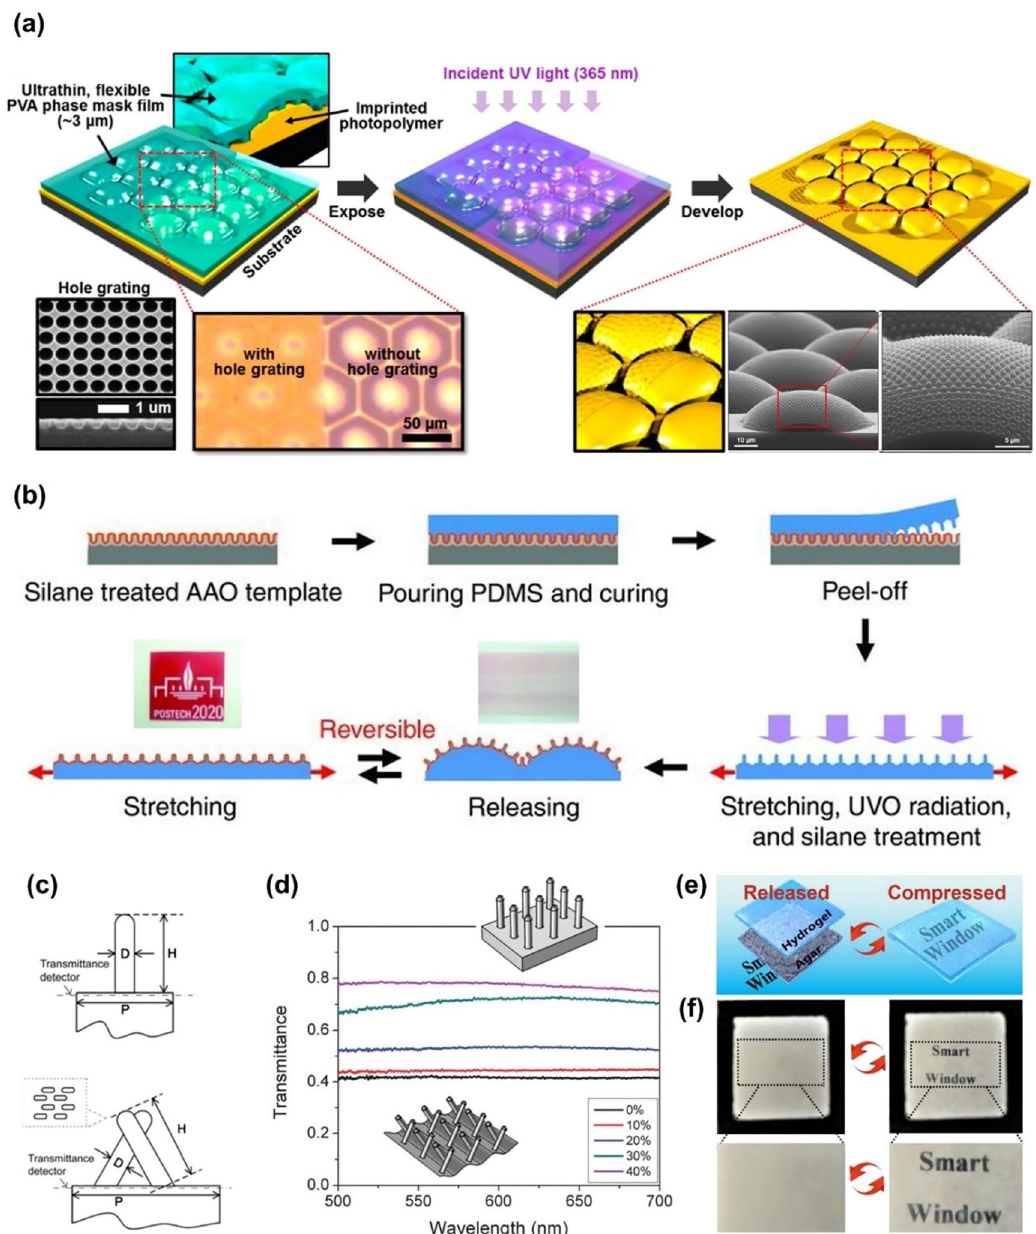
Figure 4: Fabrication of 2D scatterers based on random and hierarchical surface features. (a) Schematics describing flexible near-field phase-shift lithography (NFPSL) to fabricate nanostructure on a wavy substrate. (b) Fabrication processes for an optical thin film with hierarchical surface features, including replica molding, surface wrinkling, and treatment of the PDMS film. (c) Schematic illustration of pillar features in straight and tilted states. (d) Transmission spectrum of the hierarchical PDMS film with a wrinkled pillar array at different strains. (e) An agar/hydrogel pressure-responsive smart window showing opaqueness under release and transparency under compression. (f) The corresponding digital photos showing the optical modulation of the smart window. Reprinted with permission from Refs. [33, 63, 67,